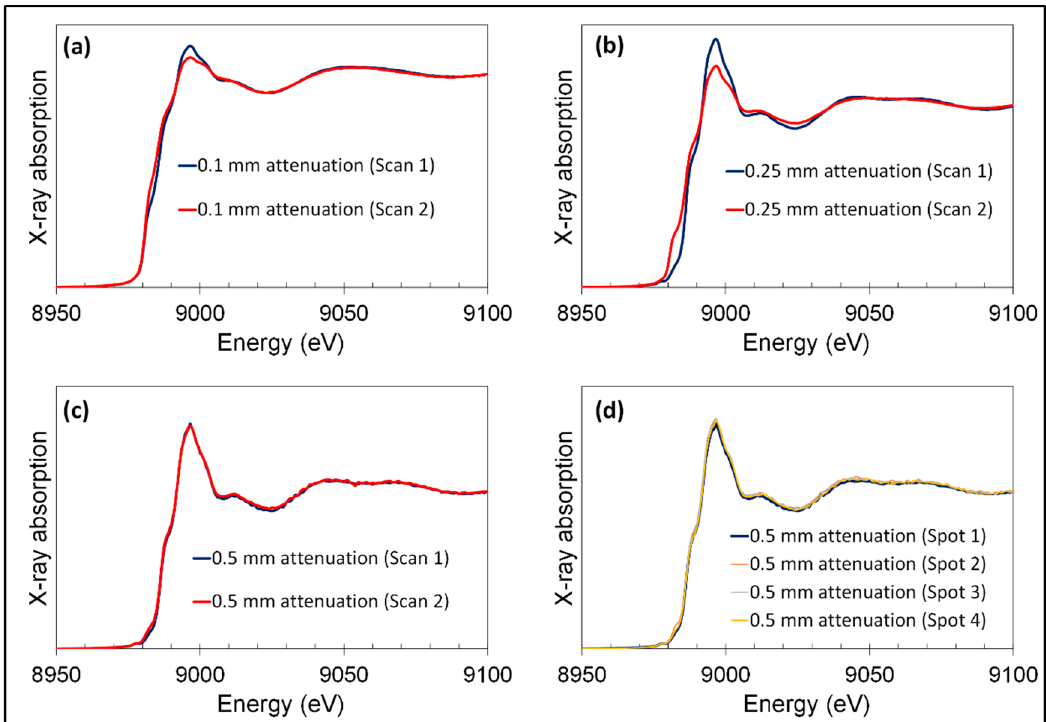
Figure A7. Optimizing measurement conditions for XANES collected from α -syn + Cu(II)SO 4 at t 0 . Repeat scans using ( a ) 0.1 mm Al attenuation, ( b ) 0.25 mm Al attenuation ( c ) 0.5 mm Al attenuation.